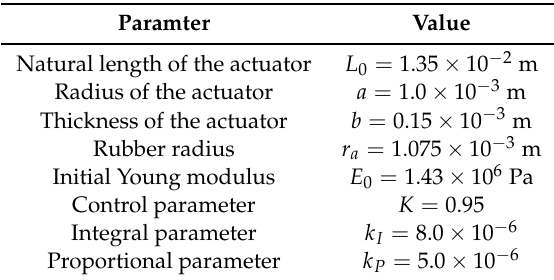
Table 3. Experimental parameters.